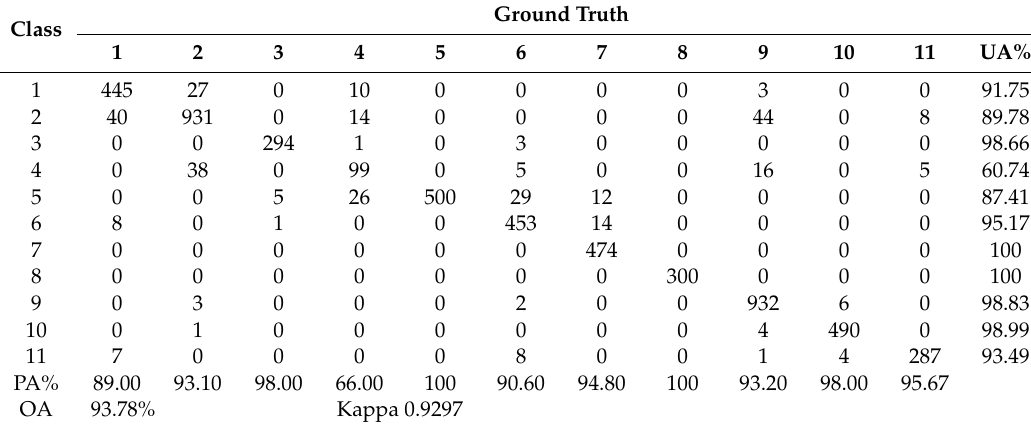
Table 4. Confusion matrix of the proposed method.